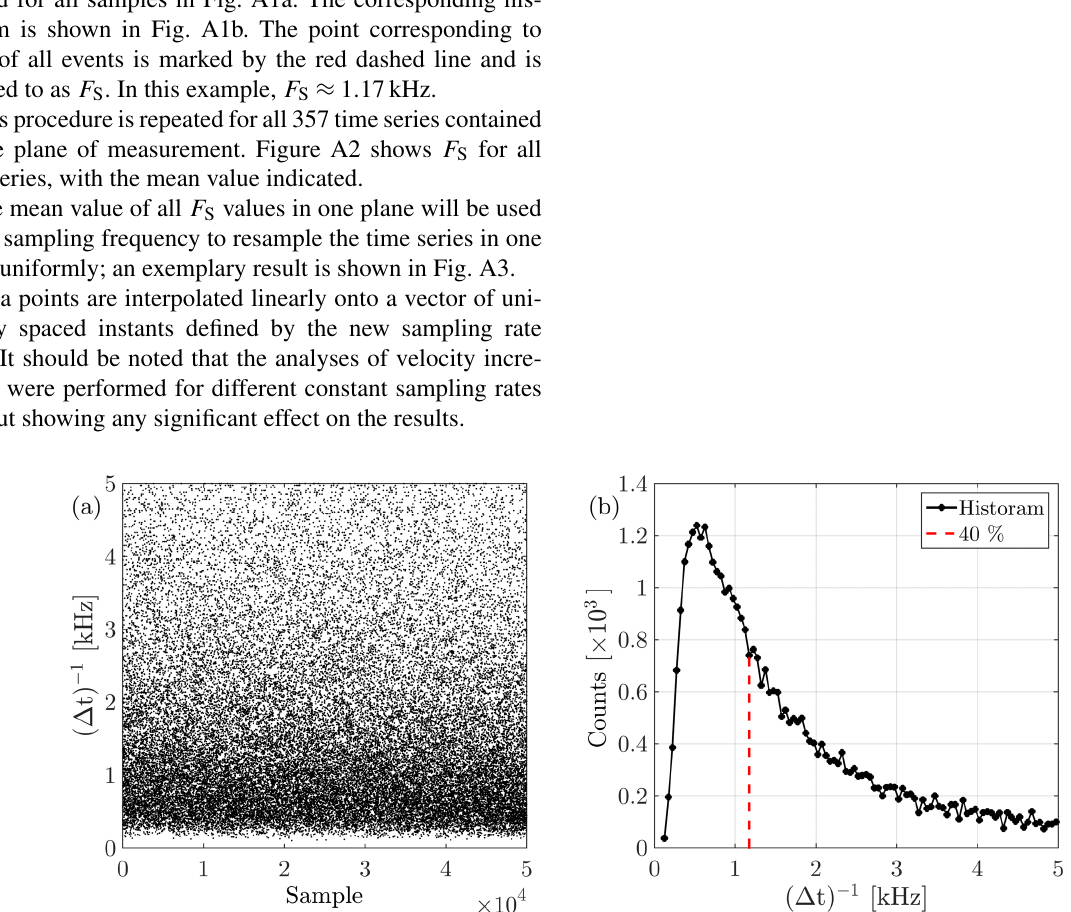
Figure A1. ( (cid:49)t ) − 1 for all samples (a) with the respective histogram (b) , where the maximum value is marked by the red dashed line.